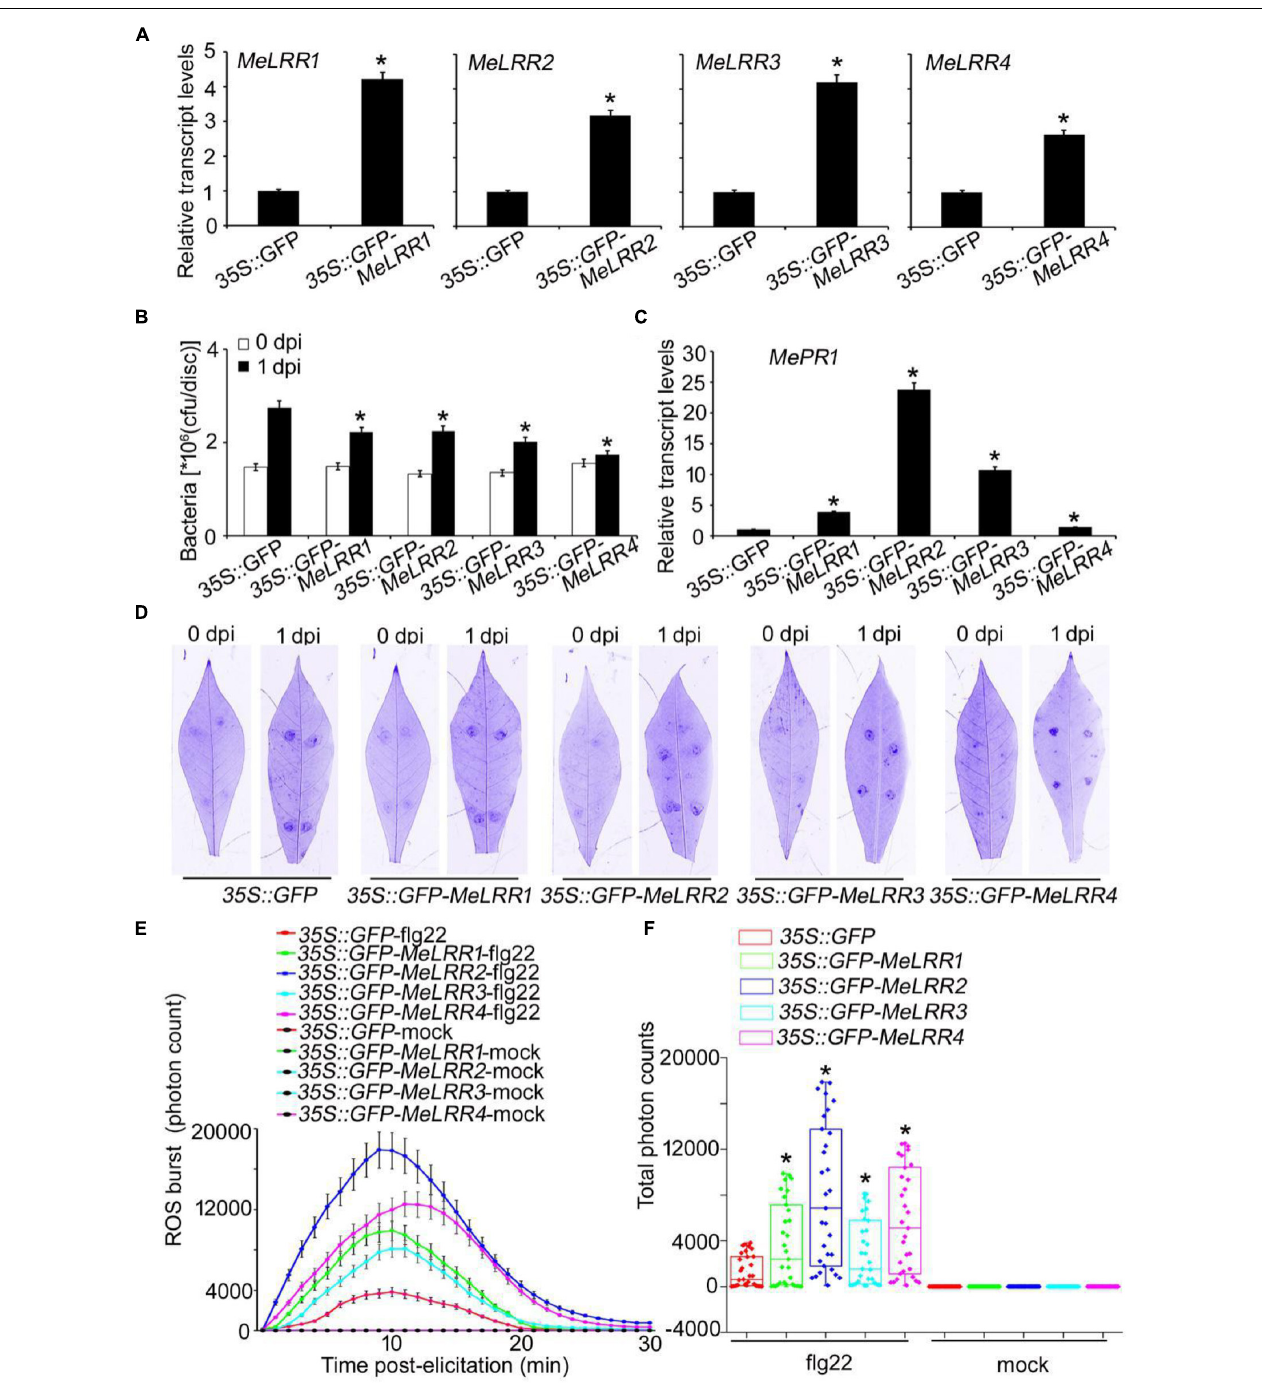
FIGURE 4 | Transient overexpression of MeLRRs improved disease resistance against cassava bacterial blight. Cassava leaves inject with recombinant pEGAD plasmids and empty vector of Agrobacterium GV3101, respectively. (A) At 3 days later, the relative transcript levels of MeLRRs in MeLRR- overexpression cassava and the pEGAD control leaves. The relative transcript levels of MeLRRs in the pEGAD control leaves was normalized to 1.0. Then, the cassava leaves were syringe infiltrated with 4 × 10 8 cfu/mL of pathogenic bacteria Xam used for disease resistance assay. (B) The number of Xam populations in MeLRR- overexpression cassava and the pEGAD control leaves at 0 and 1 dpi, respectively. (C) The pathogenesis-related gene ( MePR1 ) transcript level was quantitatively analyzed by qRT-PCR at 1 dpi. The relative transcript level of MePR1 in the pEGAD control leaves was normalized to 1.0. (D) Cassava leaves were observed using a Coomassie brilliant blue imaging system Fusion FX7-826 apparatus (Vilber Lourmat, France). (E) Dynamics of ROS accumulation in response to flg22 elicitation in MeLRR- overexpression cassava and the pEGAD control leaves. The flg22-triggered ROS burst were measured using luminol-based assay using a GloMax 96 Microplate Luminometer. (F) Total photon of MeLRR- overexpression cassava and the pEGAD control leaves. Multiple comparisons of total photon were calculated using Student’s t -test. Asterisks (*) indicate significant differences at p < 0.05. dpi is days post-infection.